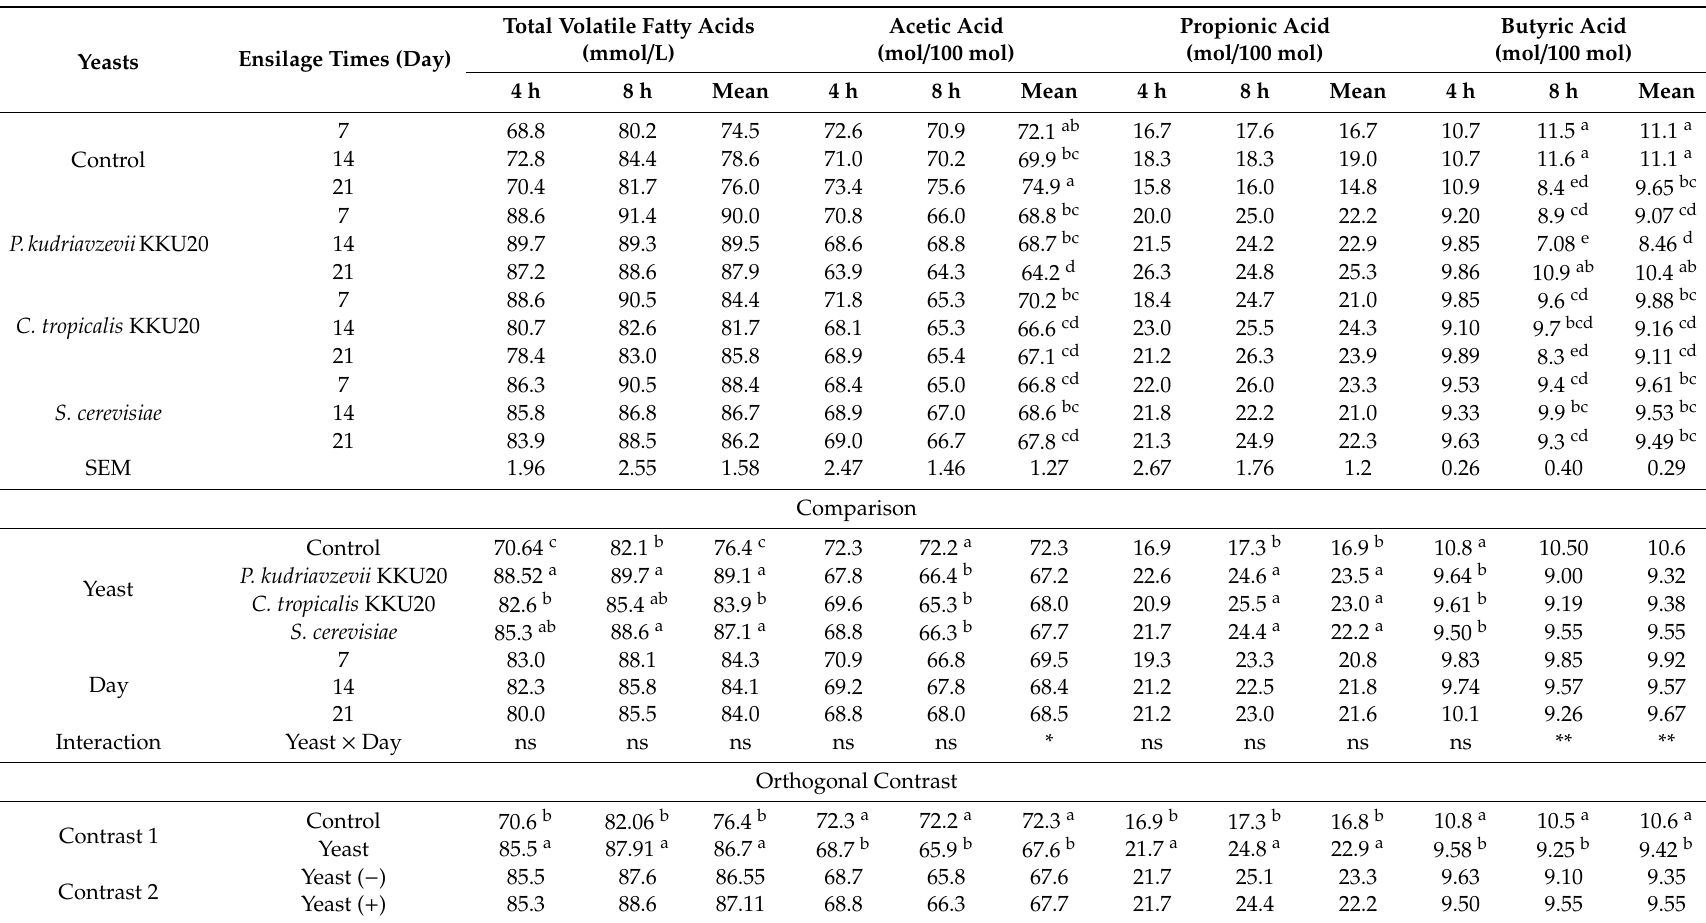
Table 5. Volatile fatty acid concentration of rice straw fermented with Crabtree-negative and -positive yeasts from in vitro